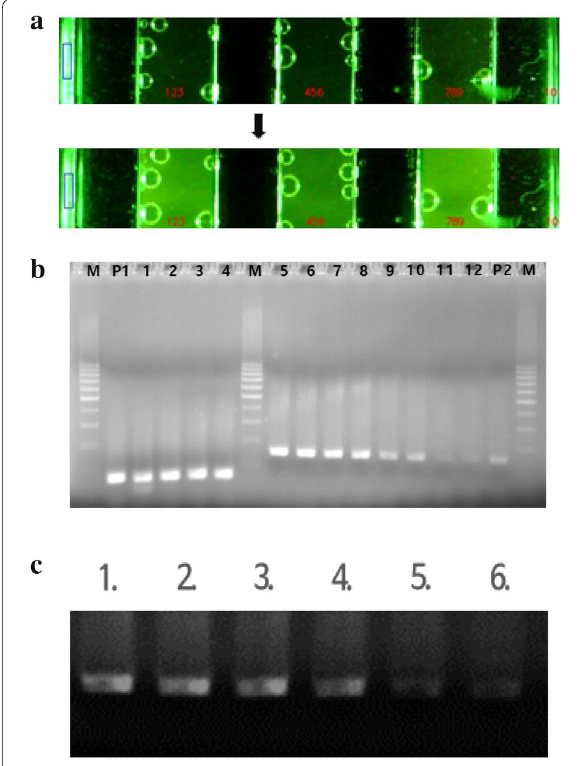
for β‑actin (amplicon size of 70 bp) genes dying SYBR green 1 before and after 40 amplification cycling in three microchambers si and, b the Agarose gel electrophoresis results for confirmation of amplification after PCR on the chip for β‑actin (lanes 1–4) and C. auriculatum (amplicon size of 150 bp, lanes 5–12) while controlling the temperatures and sustain time in steps. Here, M lanes are 25 bp marker, P1 is PCR products to β‑actin and P2 is PCR products to Cynanchum auriculatum Royle ex Wight in a commercial thermocycler (UF‑150, Genesystem Co., Ltd.) with the same temperature conditions in about 1 h, respectively. c The gel electrophoresis results as a function of starting DNA copies numbers showing the dynamic detection ranges (1.2 10 7 copies, 2.2 10 6 × × copies, 3.2 10 5 copies, 4.2 10 4 copies, 5.2 10 3 copies, and × × × 6.2 10 2 ×